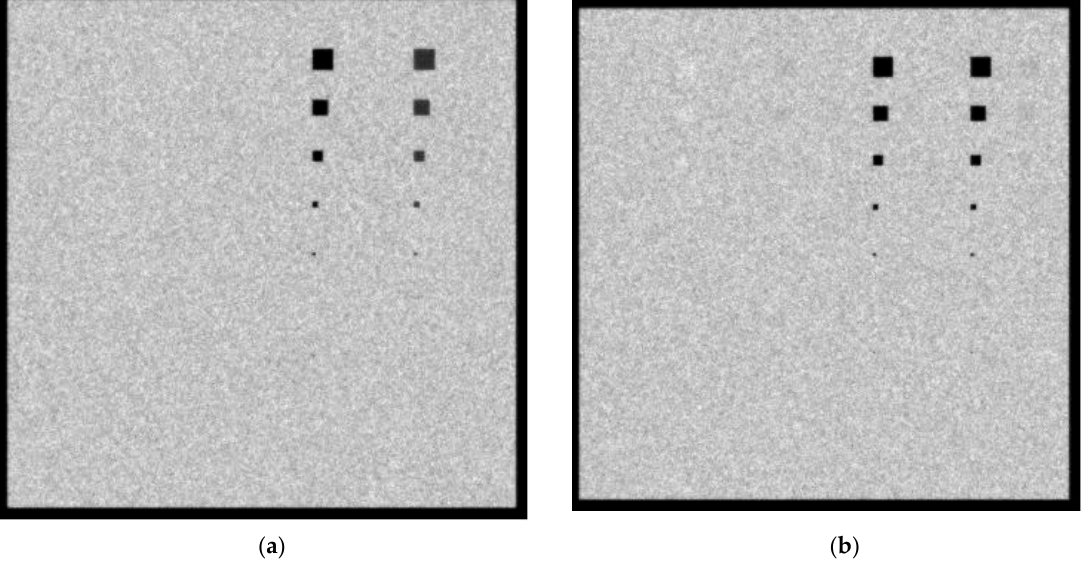
Figure 11. A 6 cm phantom image for W/Rh 5 mGy and 28 kVp spectrum with ( a ) 0.1 cm lesion thickness and ( b ) 0.5 cm lesion